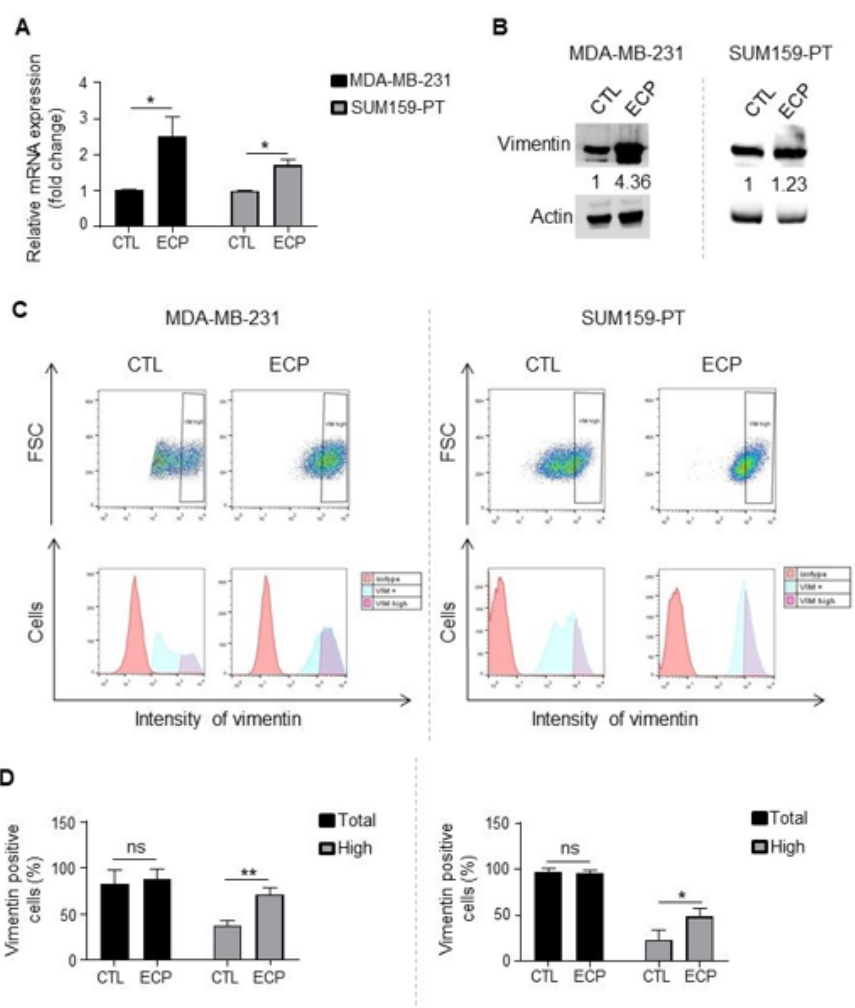
Figure 4. Vimentin expression in TNBC cells. Analyses were performed four days after ECP treatment. ( A ) Real-time PCR analysis of mRNA levels of vimentin . RPLP0 mRNA was used to normalize variability in template loading. Data from control cells were set as 1, relative mRNA expression was evaluated by fold-change. ( B ) Western blot analysis of vimentin. Actin was used as loading control. ( C ) Flow cytometry analysis of vimentin high sub-population. Cells were incubated with an antibody against vimentin and analyzed by flow cytometry with APC filter. Isotype antibody was used as control. Cells with APC fluorescence intensity ≥ log 10 3 were considered as vimentin high . ( D ) Quantification of vimentin positive and vimentin high sub-population in MDA-MB-231 cells (left panel) or SUM159-PT (right panel) cells. Quantitative graphics correspond to 3 independent experiments and illustrations are representative of 3 independent experiments. ns, not significant; *, p < 0.05; **, p < 0.01. Unpaired Student t